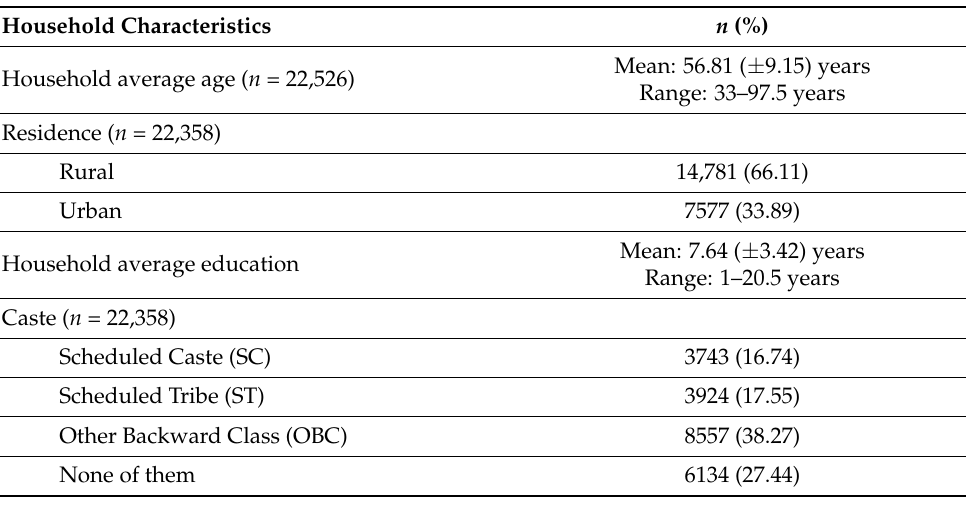
Table 1. Sociodemographic characteristics of the study population ( n = 22,526